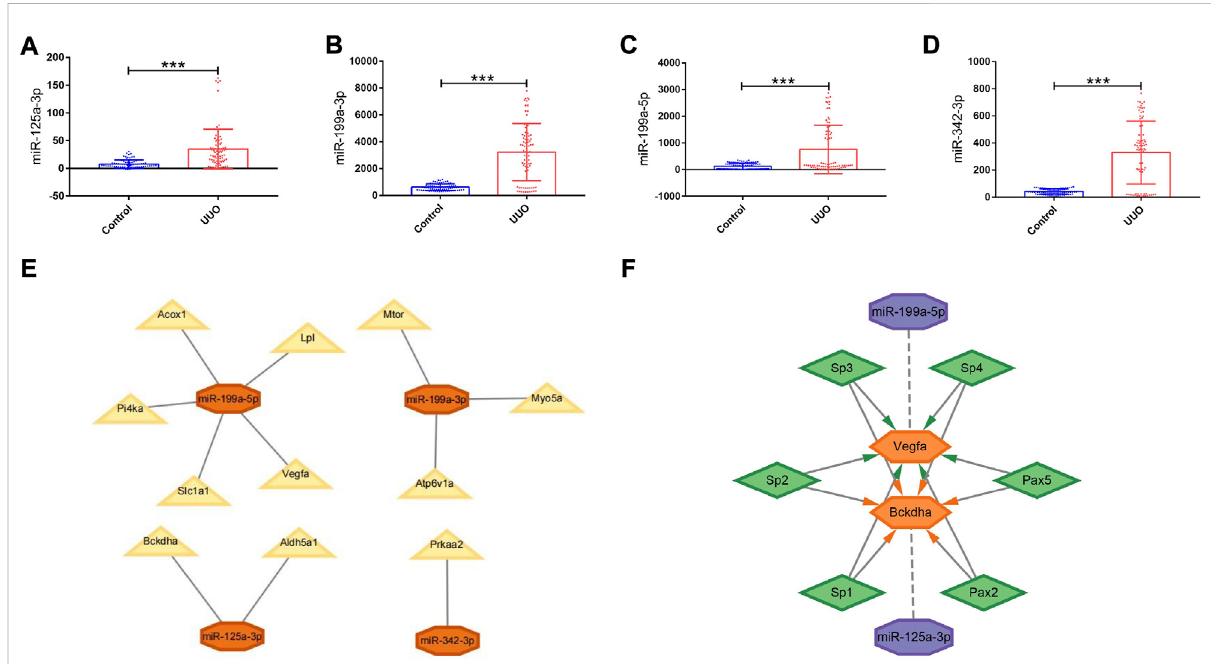
FIGURE 5 Expression levels of DEmiRNAs in the UUO group and control group, PPI network, and regulatory networks of the miRNA – mRNA and miRNA – mRNA – TF. (A – D) Expression levelsofDEmiRNAsintheUUOgroupandcontrolgroupbasedontheGSE42716dataset. (A) miR-125a-3p. (B) miR-199a-3p. (C) miR-199a-5p. (D) miR-342-3p. (E) MiRNA – mRNA regulatory network. Orange octagons represent miRNAs and yellow triangles represent mRNAs. (F) MiRNA – mRNA – TF regulatory network. Purple octagons indicate miRNAs, orange hexagons indicate mRNAs, and green diamonds indicate TFs. DEmiRNAs, differentially expressed miRNAs; UUO, unilateral ureteral obstruction; TF, transcription factor. * p < 0.05; ** p < 0.01; and *** p <